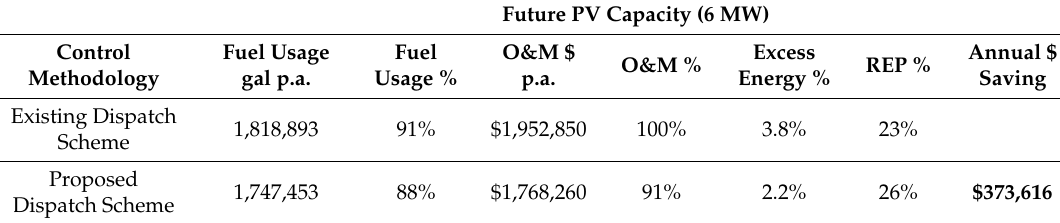
Table 8. Performance of existing and proposed low-load dispatch scheme 6 MW solar